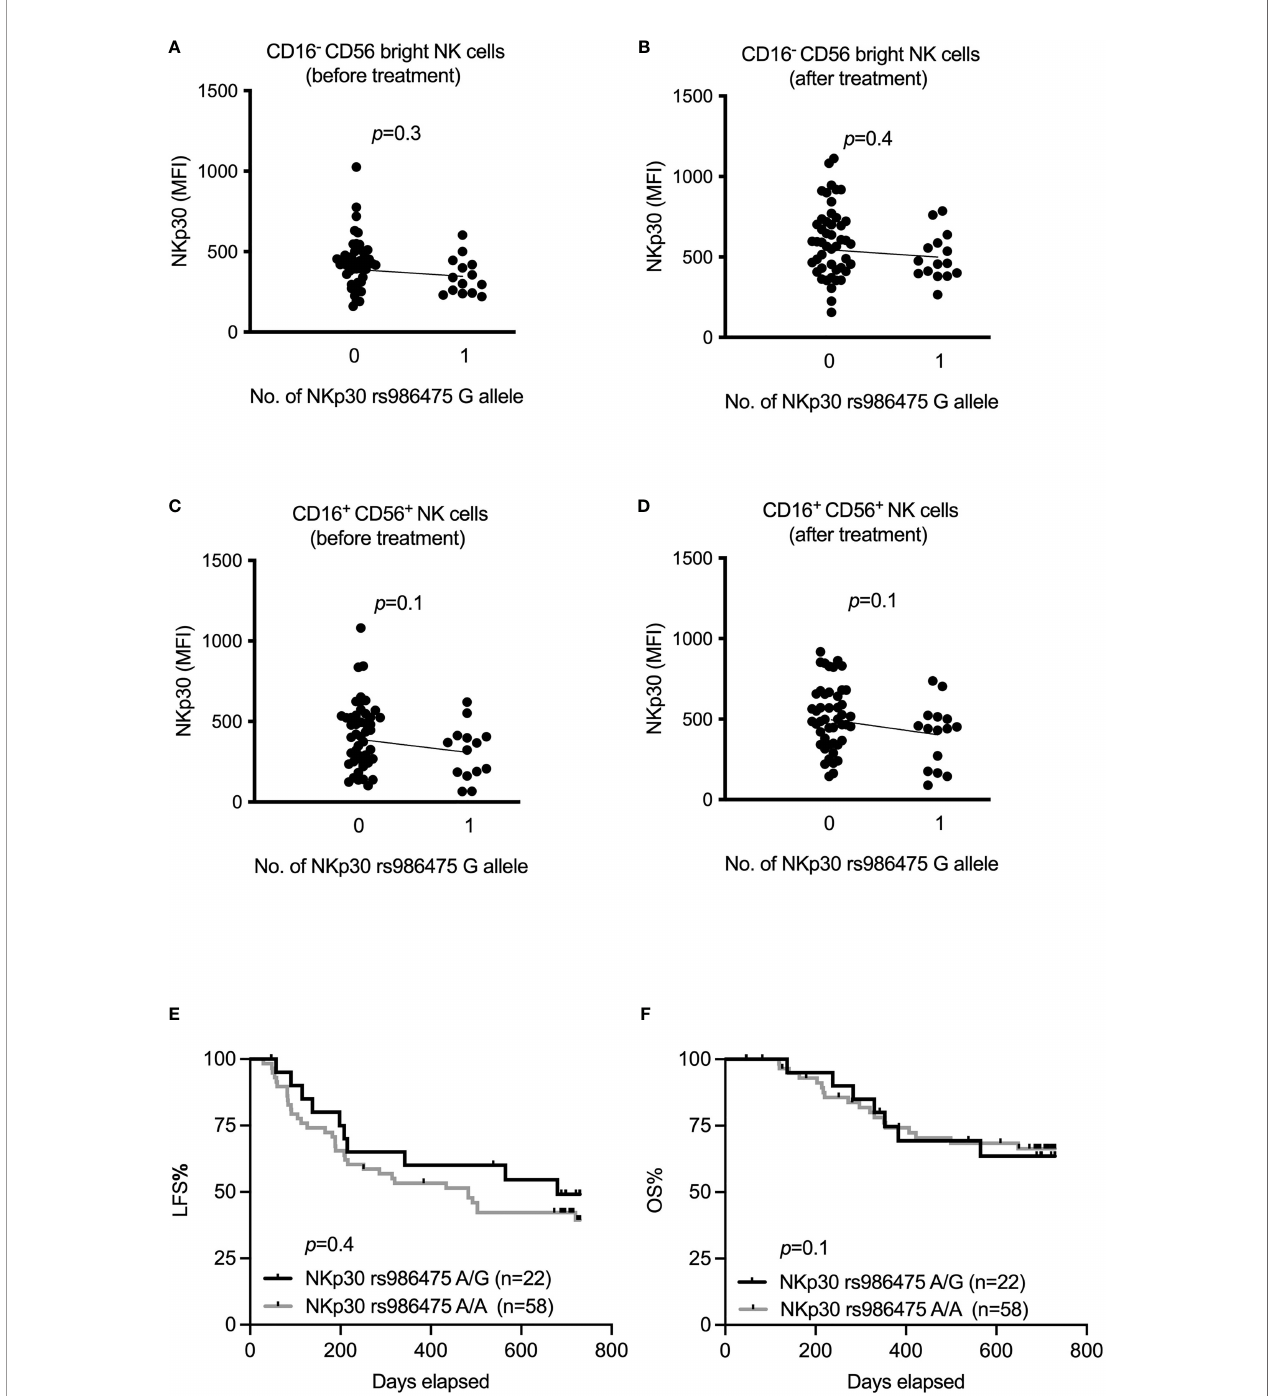
FIGURE 3 | Impact of NKp30 rs986475 gene polymorphism on expression of NKp30 and clinical outcome of AML during immunotherapy. (A – D) Median fl uorescence intensity of NKp30 based on genotype status of NKp30 rs986475 in AML patients in both CD16 - CD56 bright and CD16 + CD56 + NK cells before and after receiving one cycle of HDC/IL-2 therapy. Patients are divided according to presence (14 out of 61 before therapy, and 15 out of 62 after therapy) or absence of G allele in fi gures (A – D) . (E, F) Kaplan-Meier curves show impact of different NKp30 rs986475 genotypes on leukemia-free survival (LFS) and overall survival (OS) of AML patients after receiving HDC/IL-2 therapy. Simple linear regression was applied to investigate impact of NKp30 gene variants on NKp30 expression both before and after immunotherapy in various NK subsets as shown in fi gures (A – D). Logrank test was used to analyze the survival based on NKp30 gene variants in fi gures (E, F)